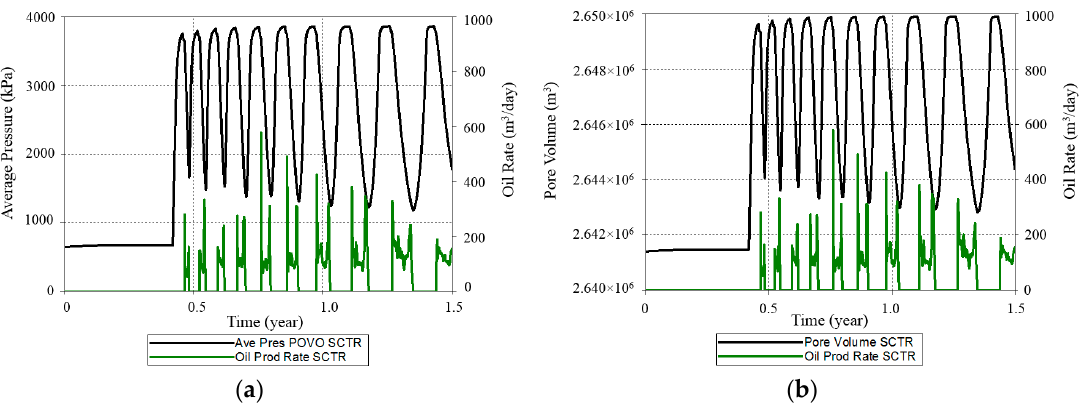
Figure 16. Change of the average pressure and pore volume during the hybrid CSS/SAGD process: ( a ) relationship between pressure, oil rate and time; ( b ) relationship between pore volume, oil rate and time.